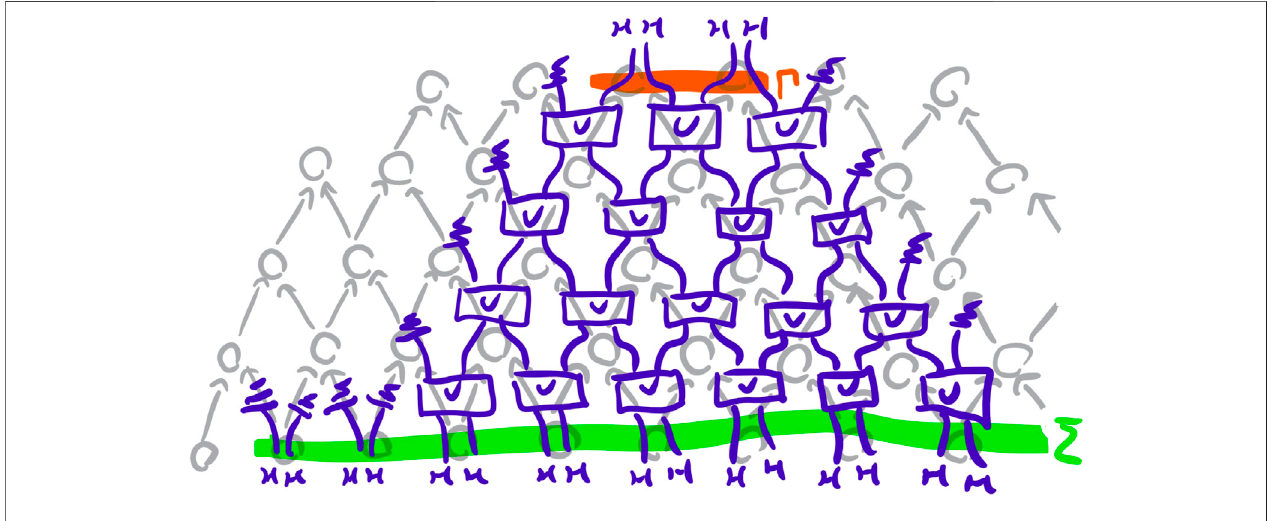
FIGURE 7 | Action of a partitioned causal cellular automaton over a complicated morphism Σ 9 Γ in the ( 1 + 1 ) -dimensional example of the diamond lattice. Here N (cid:2) { ± 1 } ,soeacheventinthecausalorderisassociatedtoacopyof H ⊗ N (cid:4) H ⊗ H .TherestrictionactionoftheCCA( Eq.45 )canbeseenonthetwoeventsatthebottomleft. ThepureevolutionactionoftheCCA( Eq.46 )canbeseenonthecentralpyramidoftenevents,astheapplicationof U withoutdiscarding.Theevolution+marginalisationactionof theCCA( Eq.48 )canbeseenontheeighteventsatthesidesofthecentralpyramid,astheapplicationof U followedbydiscardingofoneofthetwooutputs.Theinputofthe morphismdepictedconsistsofeightcopiesof H ⊗ H ,oneforeacheventof Σ ,whiletheoutputofthemorphismdepictedconsistsoftwocopiesof H ⊗ H ,oneforeacheventof Γ